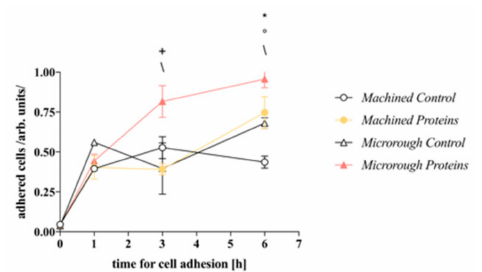
Figure 2. Cell adhesion. Time course of MC3T3-E1 cells adhesion to machined and microrough titanium surfaces pre-conditioned or not with serum proteins 1, 3, and 6 h after seeding; 2-way ANOVA: Machined Control vs. Machined Proteins * = p < 0.05; Machined Control vs. Microrough Control ◦ = p < 0.05; Machined Proteins vs. Microrough Proteins + = p < 0.05; Microrough Control vs. Microrough Proteins \ = p < 0.05.